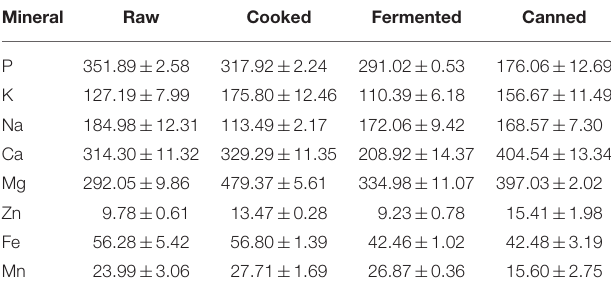
TABLE 5 | Changes in mineral contents of African oil bean seeds during processing (mg/kg dry